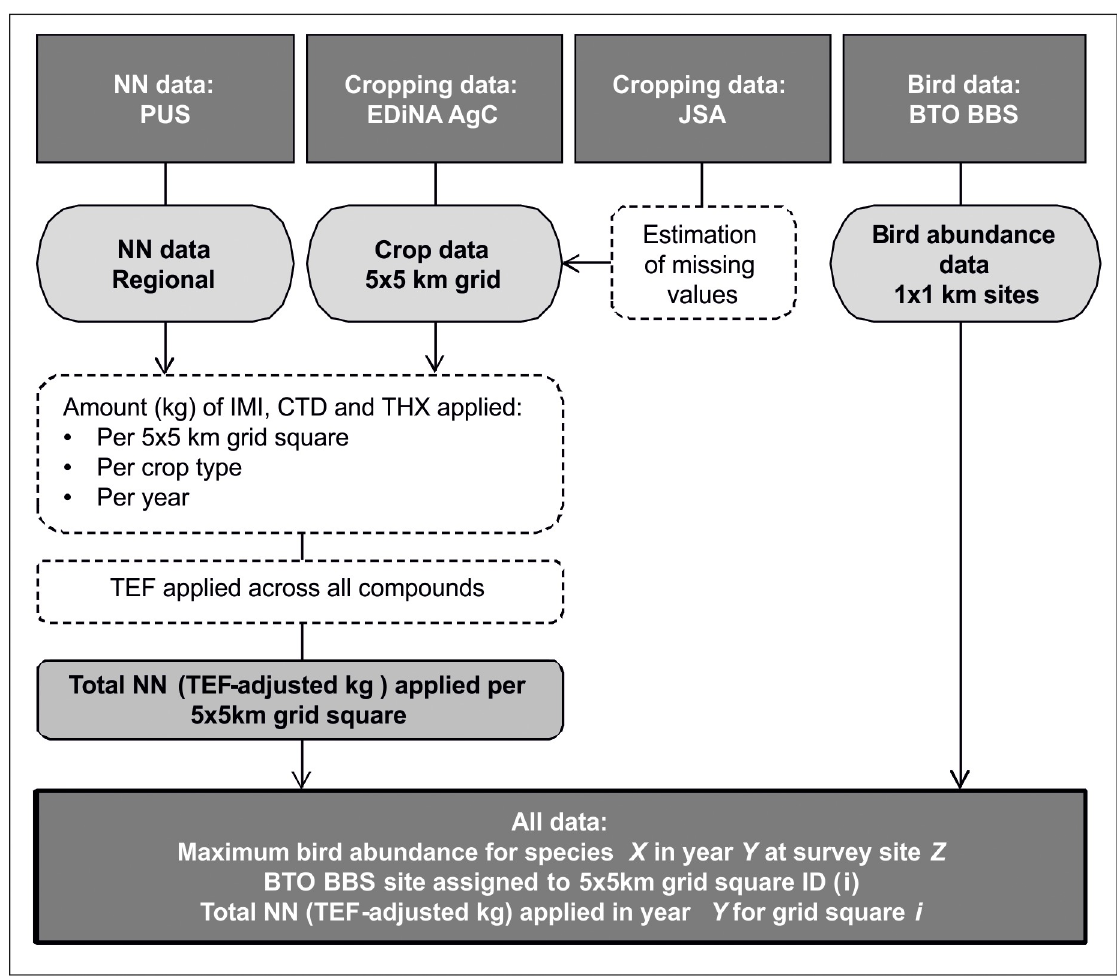
Fig 2. Overview of the manipulation process used to combine independent data sources to build the final model data frame. AgC: EDiNA agcensus; BBS: breeding bird survey; BTO: British Trust for Ornithology; CTD: clothianidin; IMI: imidacloprid; JSA: June Survey of Agriculture; NN: neonicotinoid; PUS: Pesticide Usage Survey; TEF: toxicity equivalency factor (used to adjust for the differences in toxicity of each compound to birds); THX: thiamethoxam.